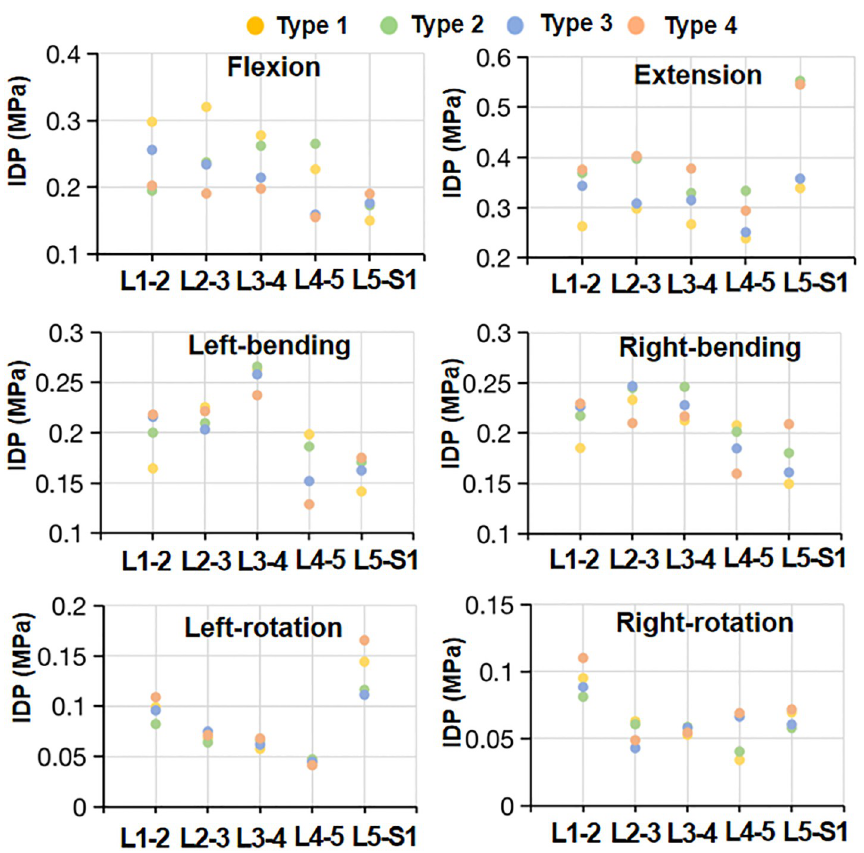
Fig 7. Scatter plots of intradiscal pressure (IDP) of the lumbar-sacral segments in the four sagittal type models for all six load cases.